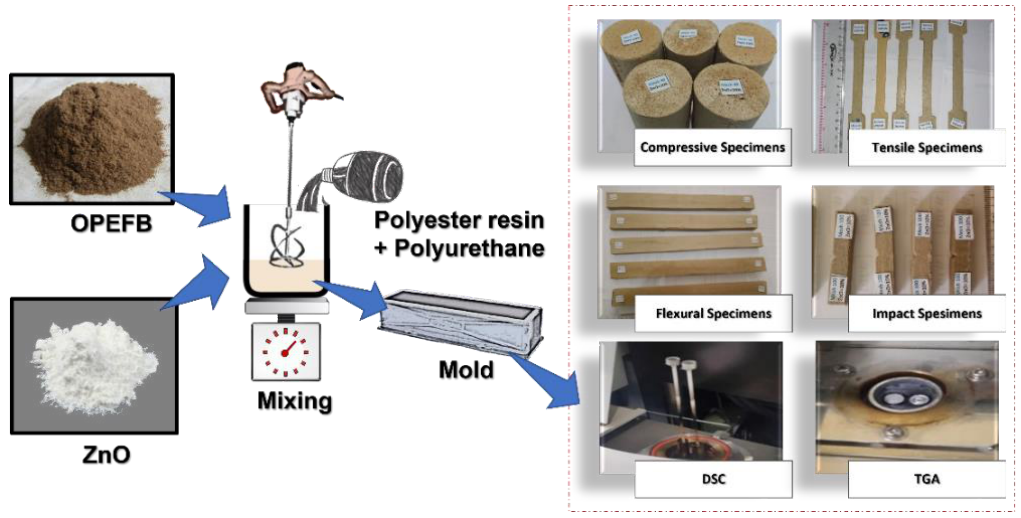
Figure 1. Material manufacturing process.